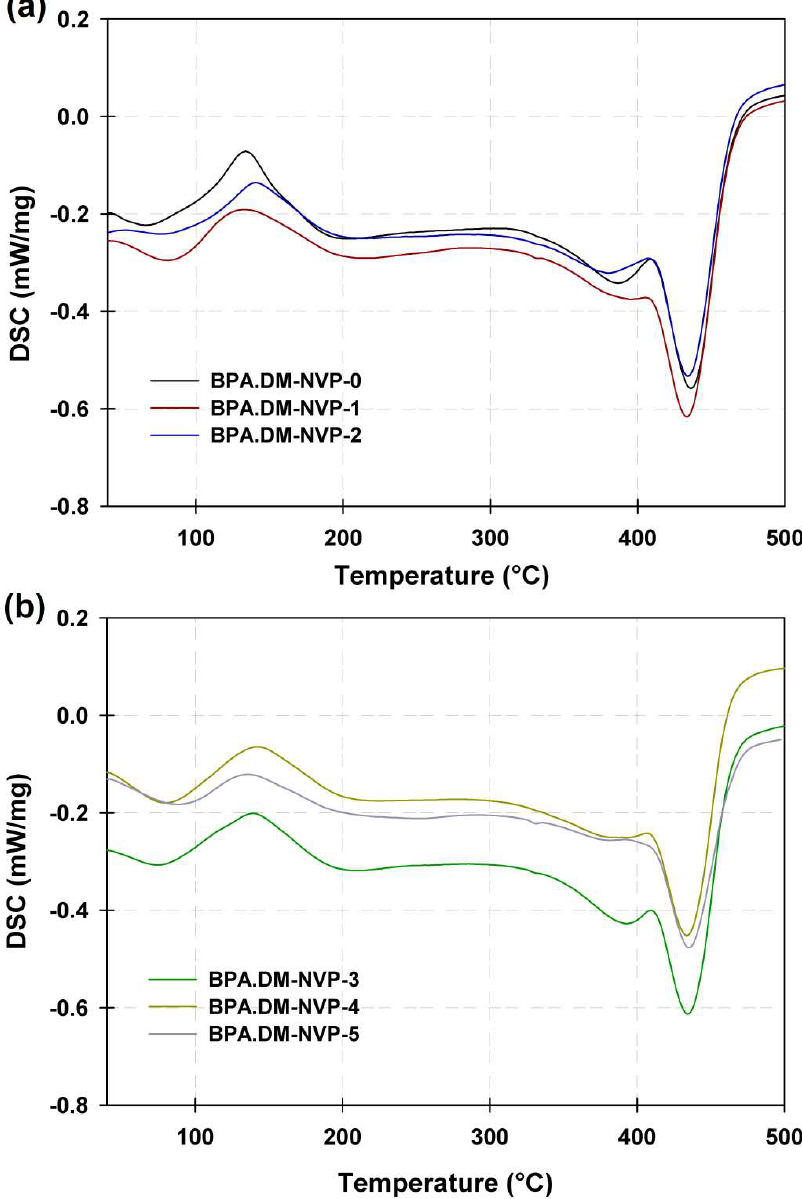
Figure 6. DSC curves of the polymer composites: BPA.DM-NVP-0–BPA.DM-NVP-2 ( a ) and BPA.DM-NVP-3–BPA.DM-NVP-5 ( b ).